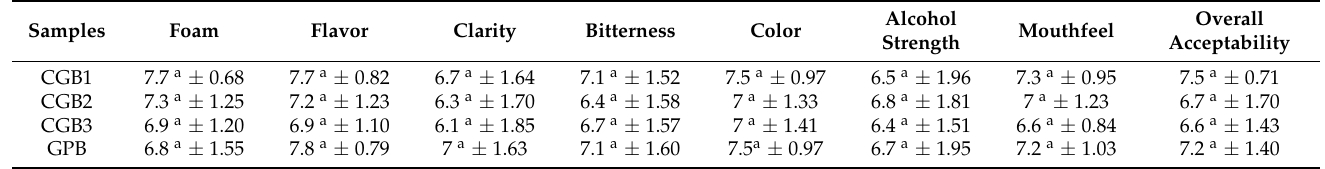
Table 4. Scores of sensory properties of